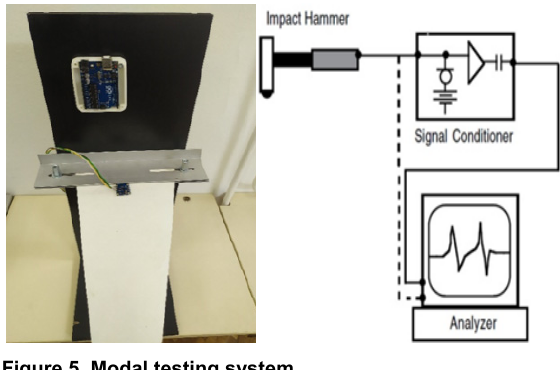
Figure 5. Modal testing system